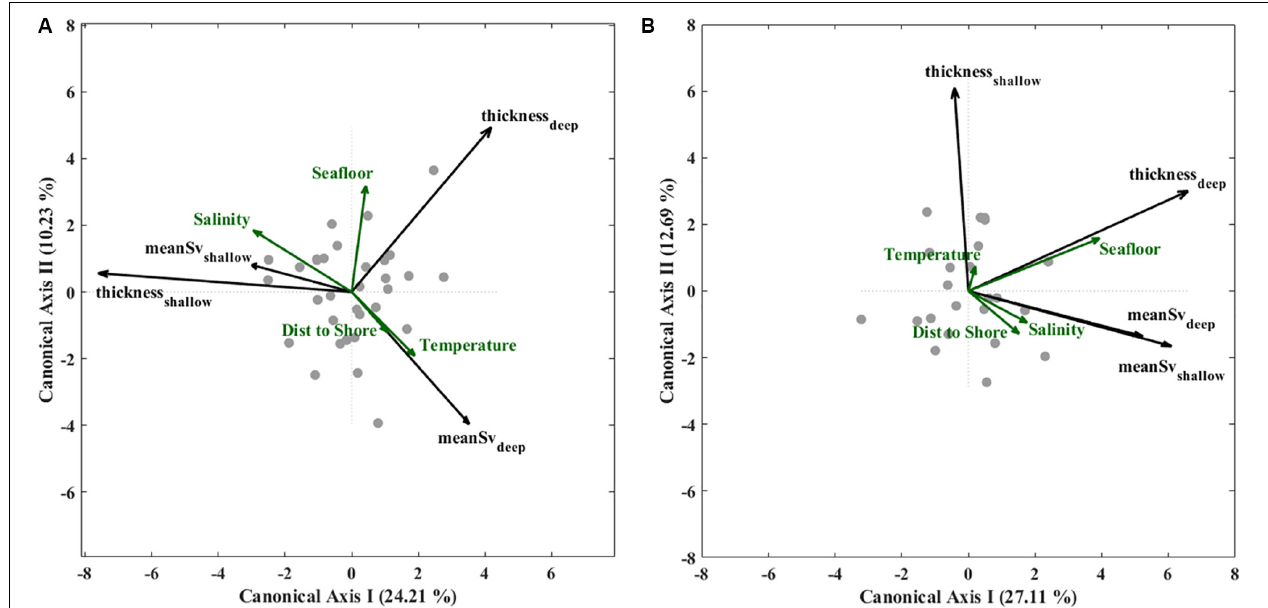
FIGURE 6 | Ordination plots for transit 1 (A) transit 2 (B) of results from redundancy analysis (RDA) for the first two canonical axes applied to two SL descriptive metrics: average S v (dB re 1 m − 1 ) and integrated S v (dB layer − 1 ) for shallow and deep SLs (black vector arrows); and for glider-derived environmental variables: deep salinity (g kg − 1 ) and temperature ( ◦ C) from 90 to 100 m depth, seafloor depth (m), and across-basin position (km) (green vector arrows). Site scores are shown as gray points in the ordination